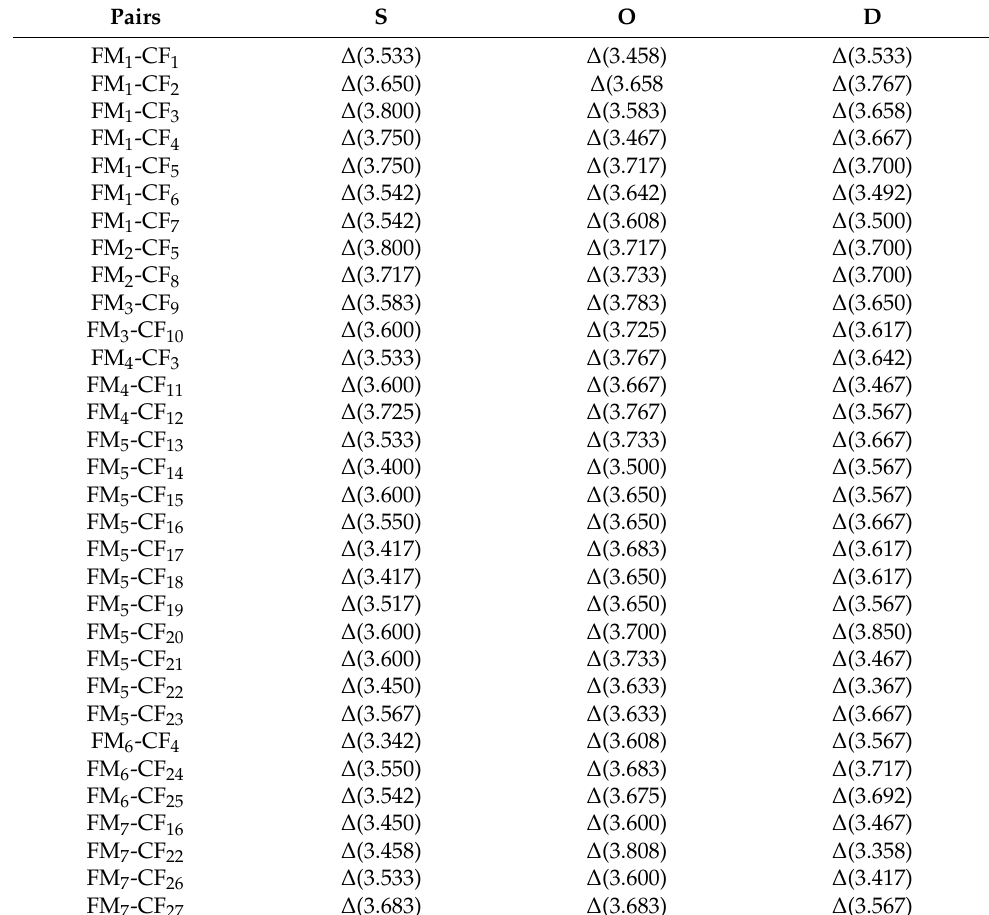
Table 8. The distance matrix D 0 for pairs of FMs and CFs.